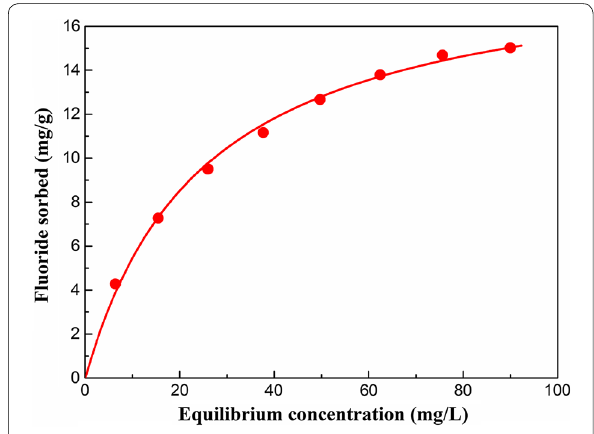
Fig. 3 Experimental equilibrium data (dots) and Langmuir fits (curves) fluoride adsorption onto LDH/BCF (adsorption time, 24 h; adsorption temperature, 30